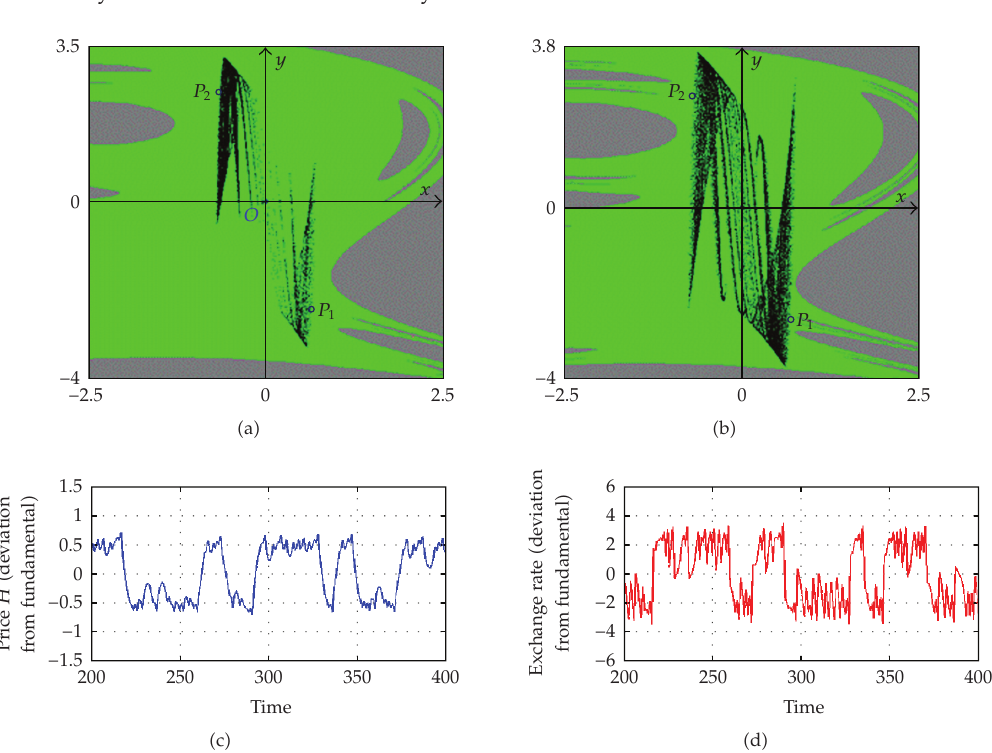
Figure 13: Homoclinic bifurcation of O and final bifurcation. In (cid:5) a (cid:6) , we take e (cid:8) 4 . 3, while in (cid:5) b (cid:6) e (cid:8) 4 . 893. The points that will be involved in the contact between the strange attractor and the basin boundary can easily be guessed. In (cid:5) c (cid:6) and (cid:5) d (cid:6) we represent the dynamics of the state variables x and y in the time domain, switching between bull and bear markets, for e (cid:8) 4 .